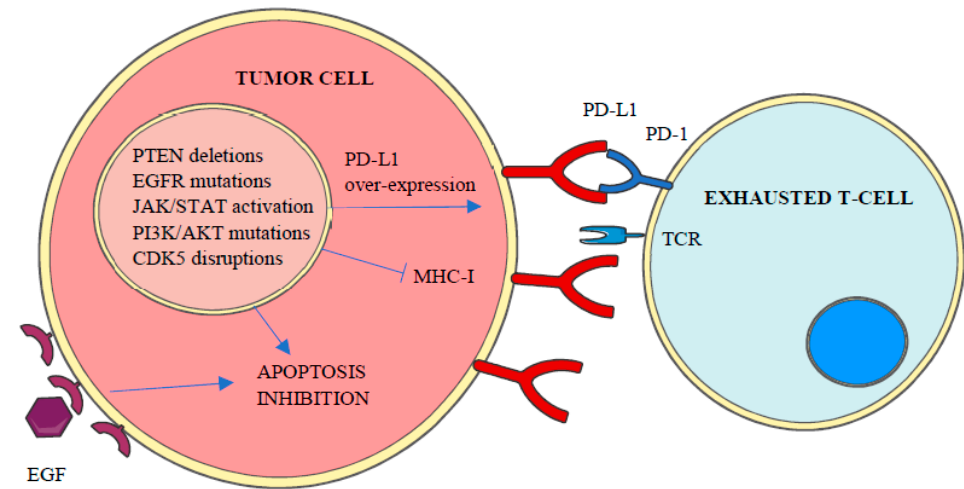
Figure 3. Aberrant expression of different kinases inhibits apoptosis and MHC-I expression and promotes PD-L1 overexpression, which leads to tumor cell enhanced survival and T-Cell inactivation or loss of recognition.